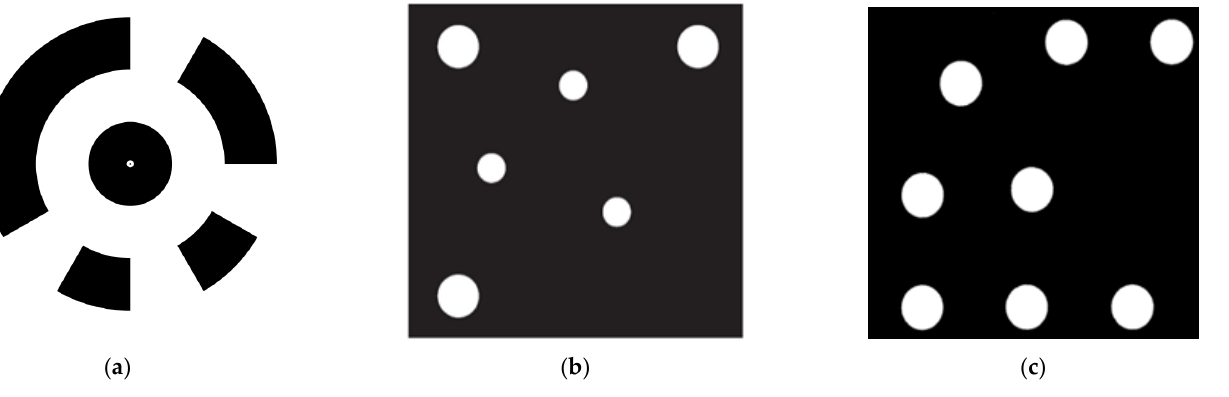
Figure 1. Three classical types of coded targets in photogrammetry: ( a ) SCT; ( b ) HCT; ( c ) GCT. SCT adopts ring designs [23]. The central circle is for positioning, and the ring band surrounding it is for decoding. It employs binary encoding, i.e., using values of 0 and 1. The ring is divided into several encoding bits, where the black bit represents 1 and the white bit represents 0. Every shape corresponds to a unique identity of coding serial number, and the coding serial number is 150 as shown in Figure 1a. HCT adopts